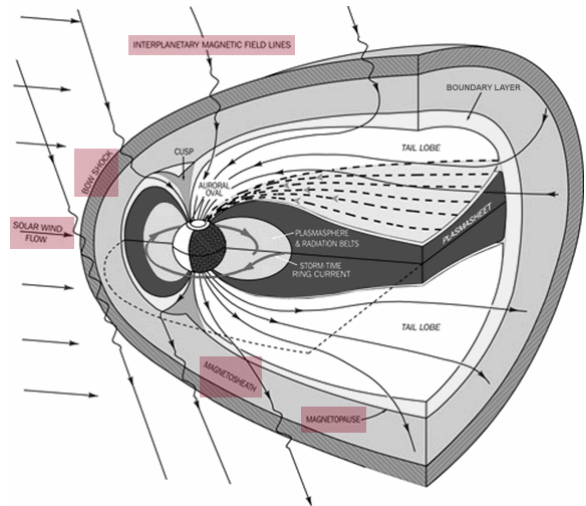
Fig. 1. 3-D picture of the Earth’s magnetosphere (adapted from http: //pluto.space.swri.edu/IMAGE/glossary/magnetosphere.html). The plasma sheet and the tail lobe regions and cusps are distorted by the solar wind flow. The solar wind ( exterior region ) is outside the magnetopause. The boundary region is completed by the boundary layers, cusp, and the plasma sheet. The inner region contains tail lobe field lines that permeate the polar cap